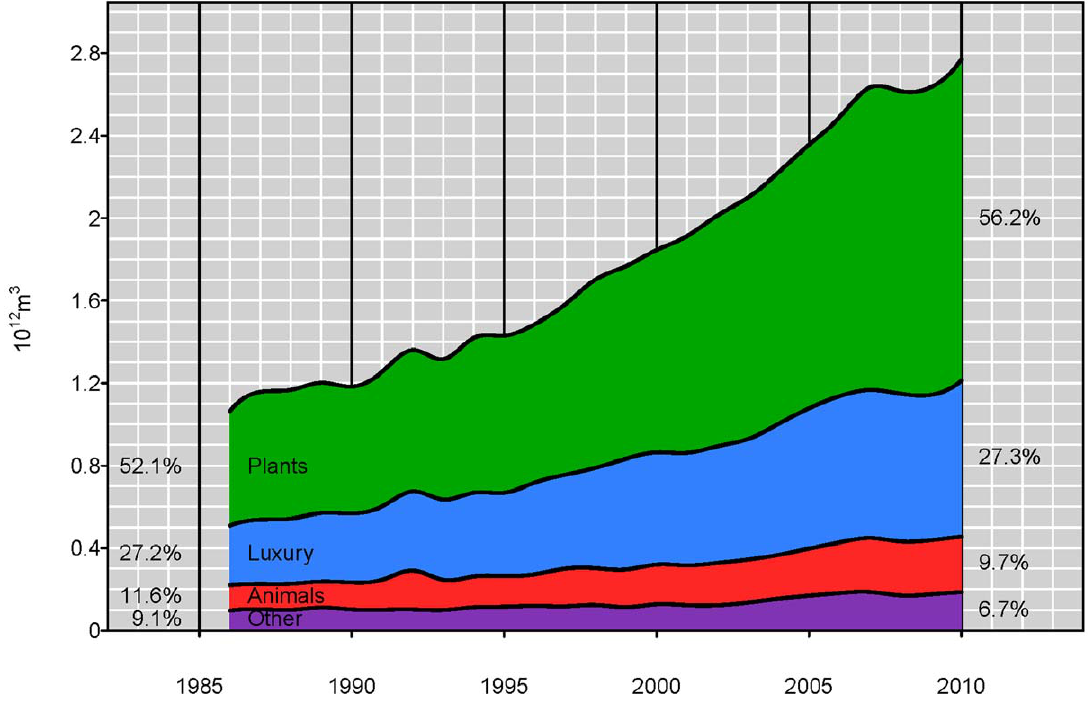
Figure 4. The increase in virtual water trade and the percentage of the total virtual water flux in the network corresponding to plant, animals, luxury, and other commodities. While there is an increase in the virtual water flux associated with all commodity categories, the fraction of the total flux associated with animals and other has decreased. There is a corresponding almost tripling of crop products and luxury products over the 25 year period with animal products and fibers increasing to a lesser